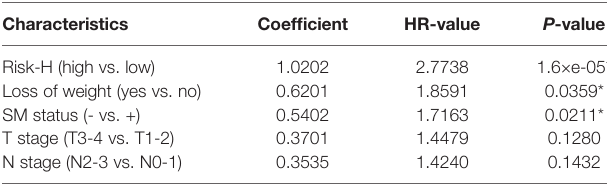
TABLE 4 | Factors included in the nomogram